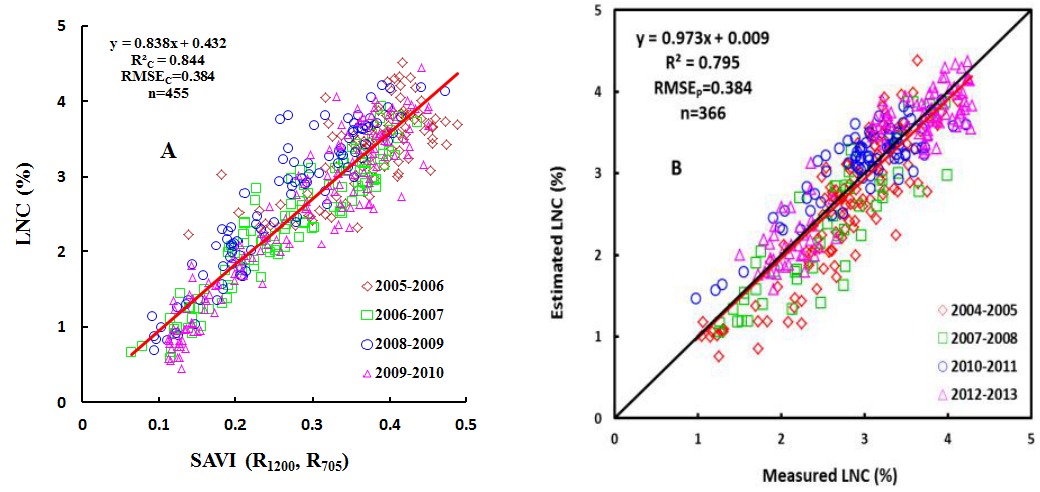
Figure 5. The relationship between SAVI(R 1200 , R 705 ) and the wheat LNC ( A ); and the 1:1 relationship between the measured LNC and those estimated values based on SAVI(R 1200 , R 705 ) ( B